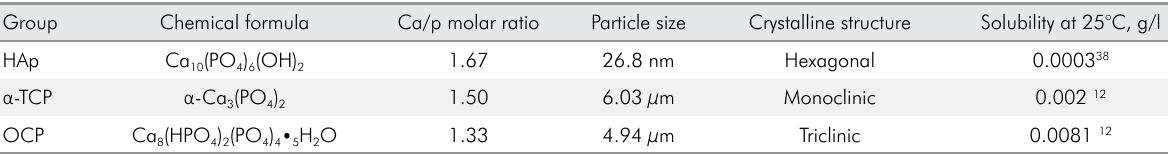
Table 1. Characterization of tested calcium phosphates